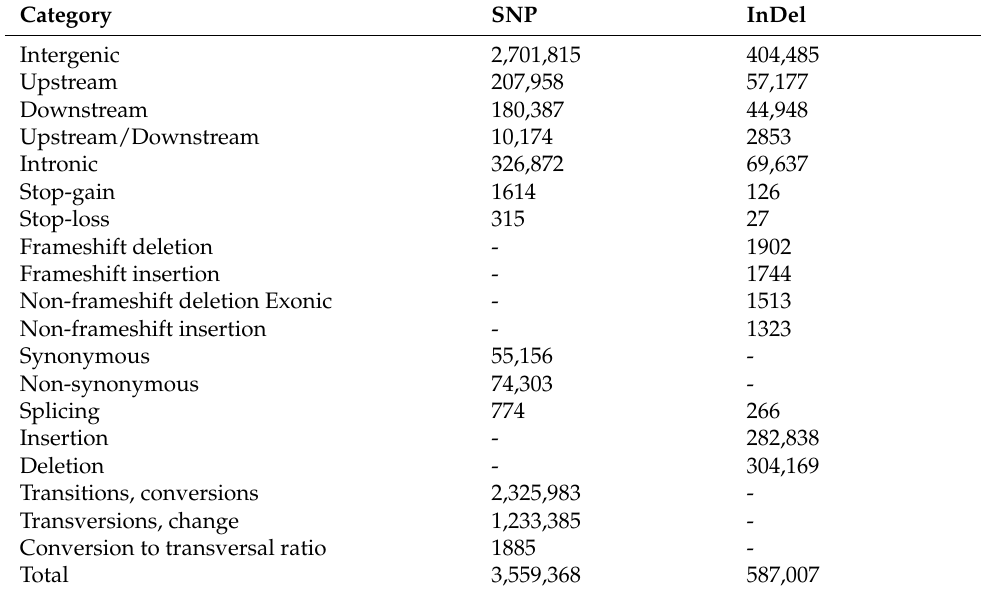
Table 3. Numbers of different types of SNPs and InDels detected between the two soybean